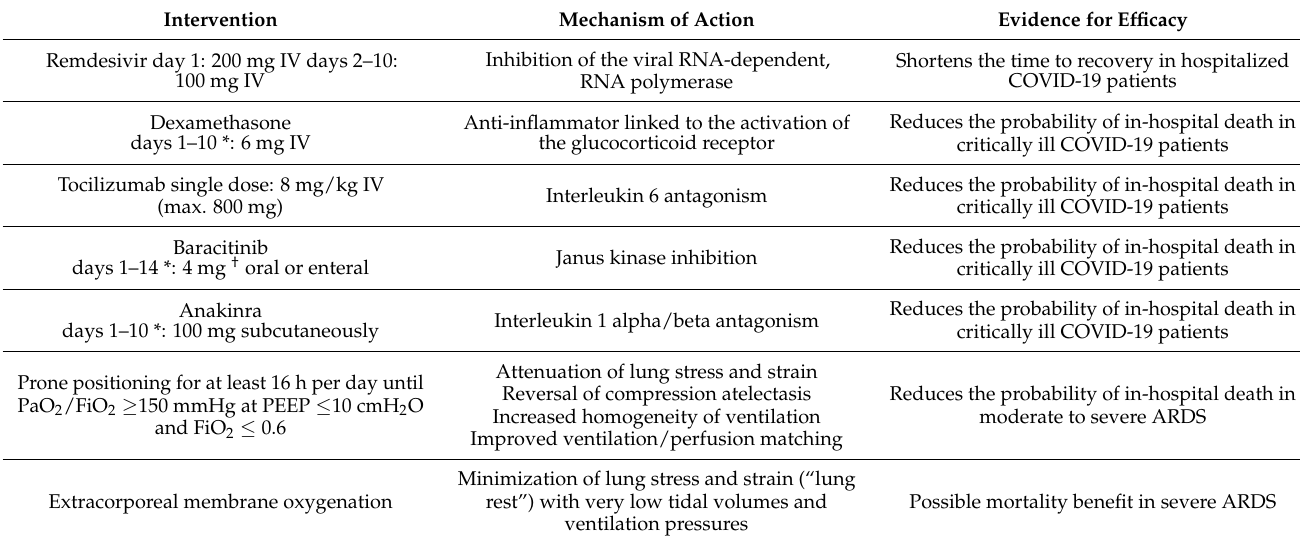
Table 3. Evidence-based treatments for coronavirus disease 19 (COVID-19)-related acute respiratory distress syndrome (ARDS). PaO 2 /FiO 2 , oxygen arterial partial pressure-to-inspired oxygen fraction ratio; PEEP , positive end-expiratory pressure. * Time interval corresponds to the maximum recommended duration of therapy. † To be reduced to 2 mg if estimated glomerular filtration rate is 60 mL/min or less. Intervention Mechanism of